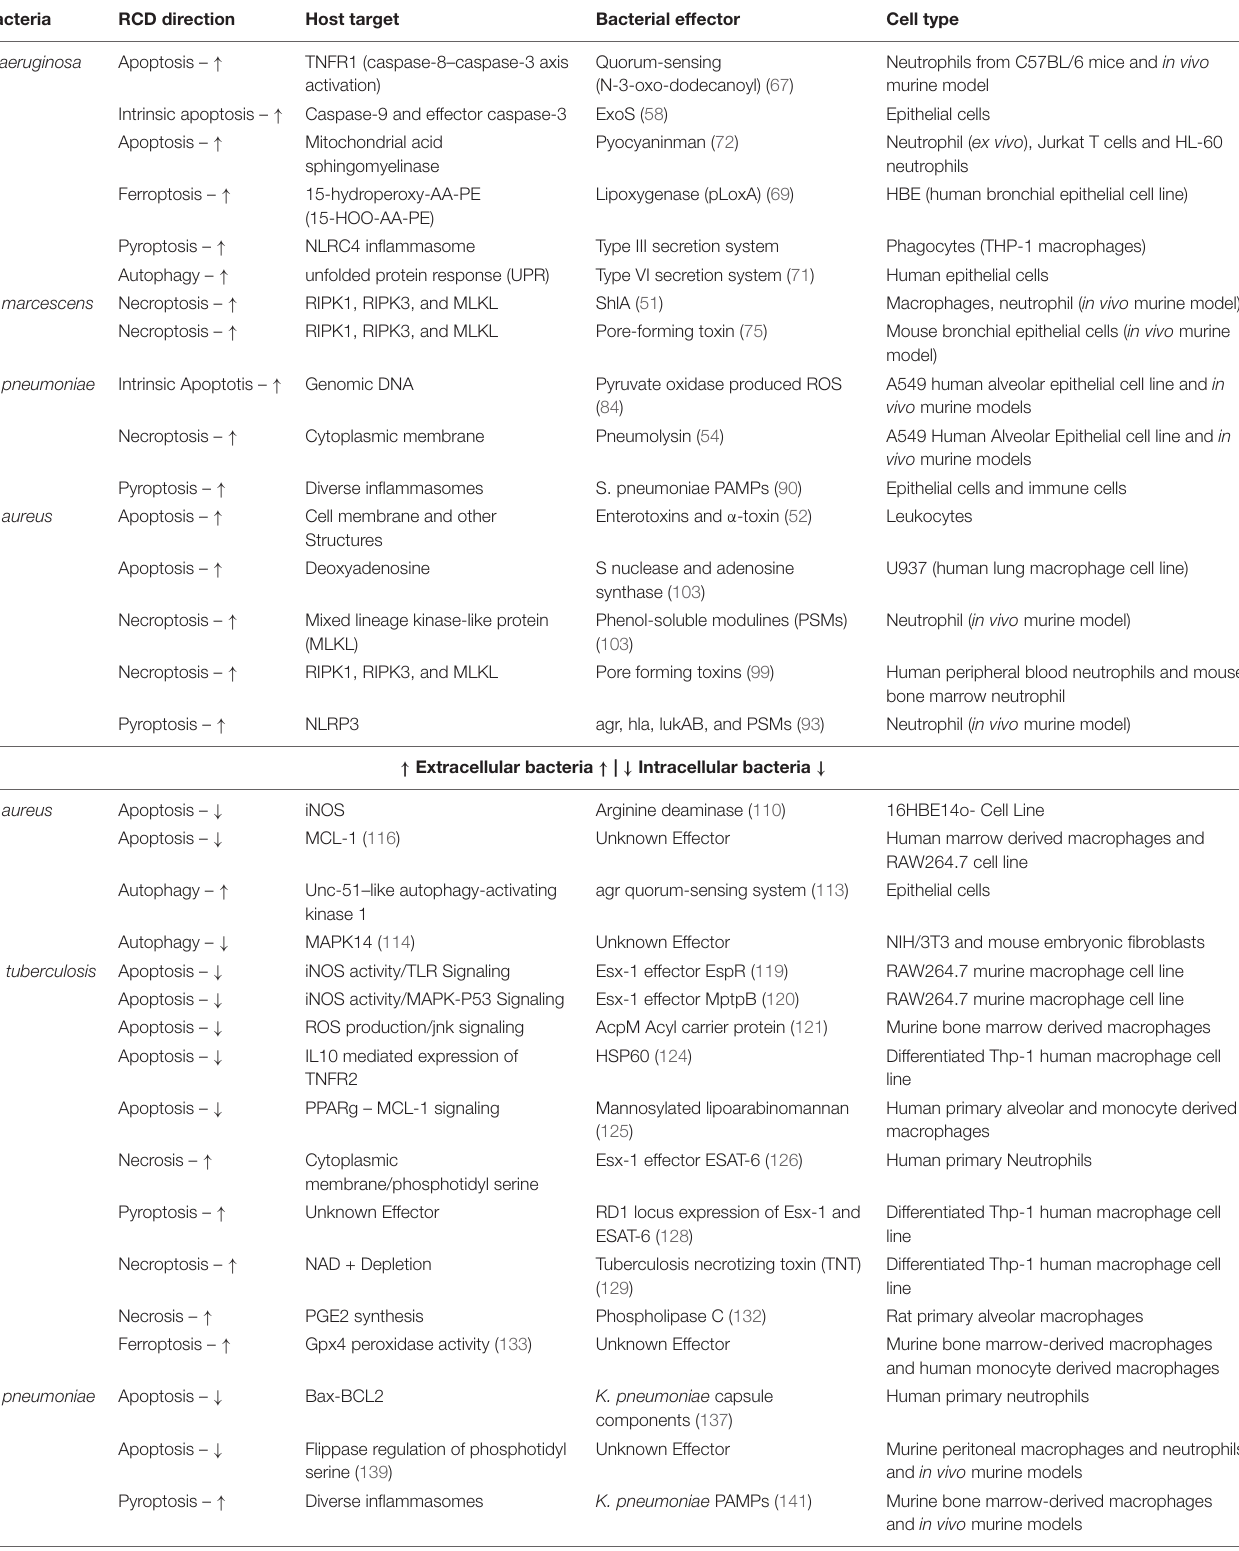
TABLE 1 | RCD directionality through diverse pulmonary bacterial infections.